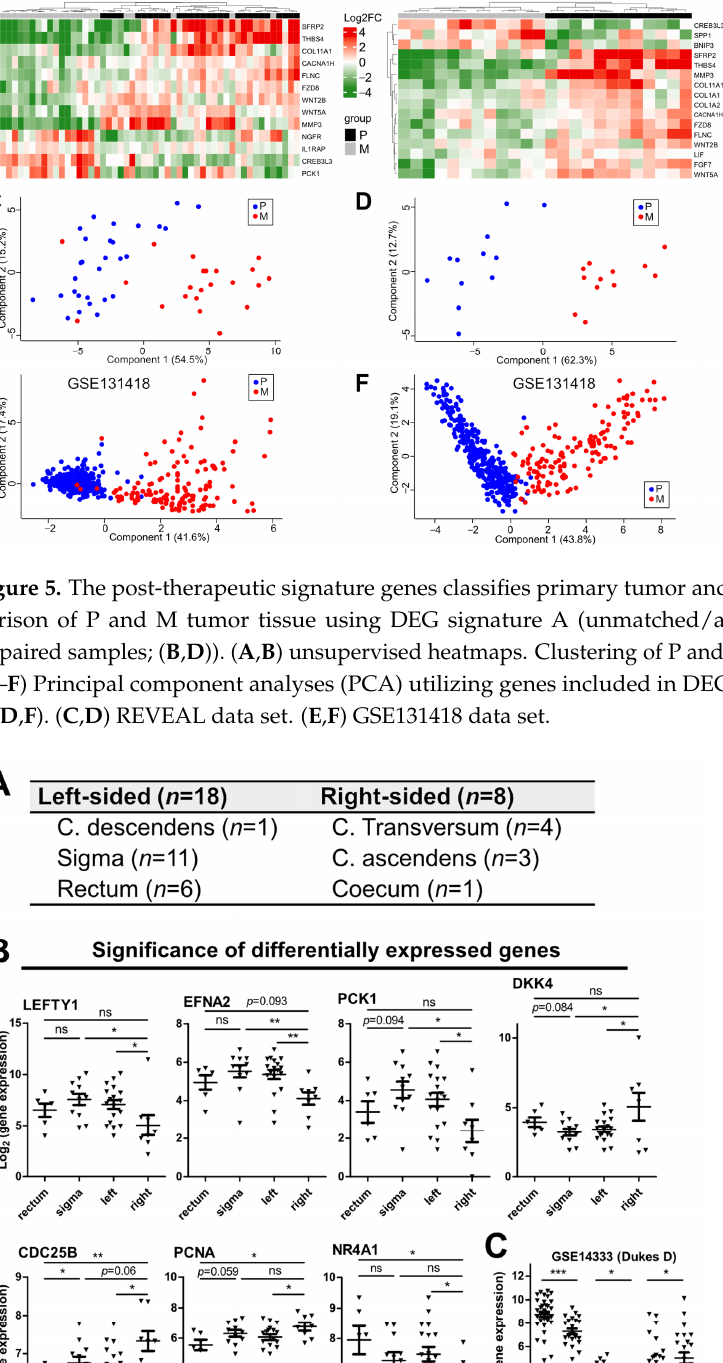
Figure 6. ( A ) Primary tumor localization of samples available for CRC sidedness association anal- yses. ( B ) Differentially expressed genes (DEGs) in primary CRCs of left- or right-sided origin. ( C ) Confirmation of side association of PCK1, EFNA2, and DKK4 expression in the independent data set GSE14333 (only Dukes’ D stage). ( B , C ) Significance levels were calculated by moderated t -test with limma. *, p < 0.05; **, p < 0.01; ***, p < 0.001; ns, not